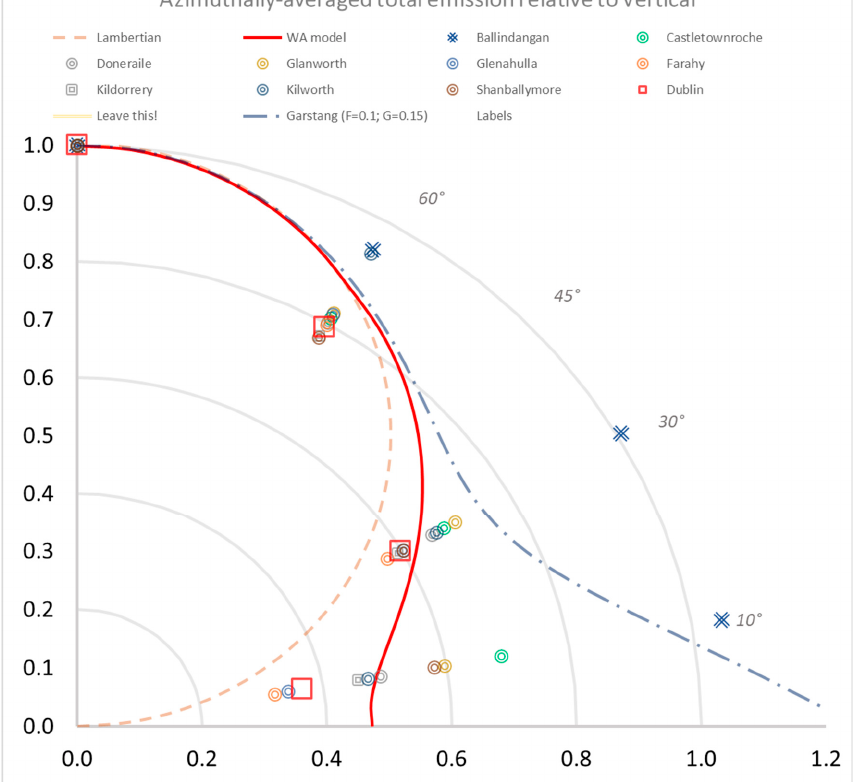
Figure 7. Azimuthally averaged total emission data (in cd) for the Irish towns normalised to the zenithal emission in each case. The data are compared with simple Lambertian emission (dashed line), the Garstang model with F = G = 0.15 (dash-dot line), and the distribution used in the New World Atlas (solid line). In all cases other than the smallest hamlet of Ballindangan (indicated by the crosses) which is dominated by direct emission from old LPS lanterns, the total emission is less than that predicted by the Garstang model although the direct emission component results in significant emission at low angles and is also more important for smaller towns. Data for the Dublin city test area is indicated by open squares. The New World Atlas model has a direct and Lambertian component but also an intermediate angle component towards 30° elevation, as described in [18].